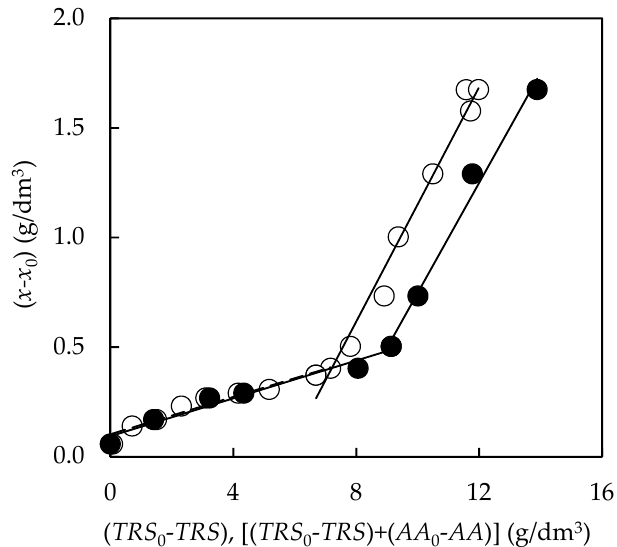
Figure 9. Biomass yield of the culture considering as substrate the total reducing sugars ( TRS ) (black points) or the sum of total reducing sugars and acetic acid ( AA ) (open points).